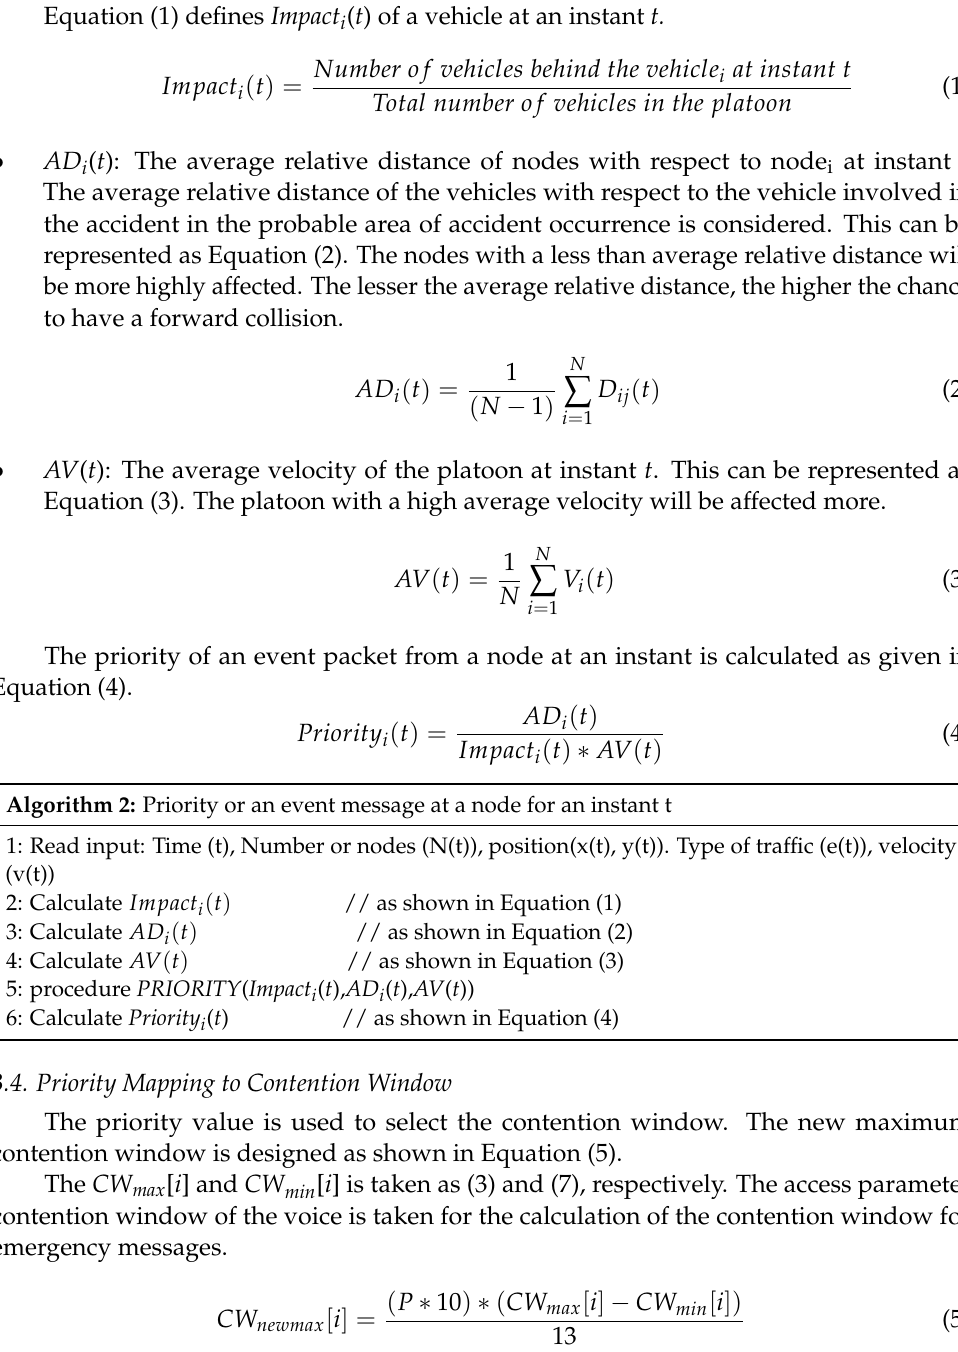
Algorithm 3 details the selection of a new maximum contention window